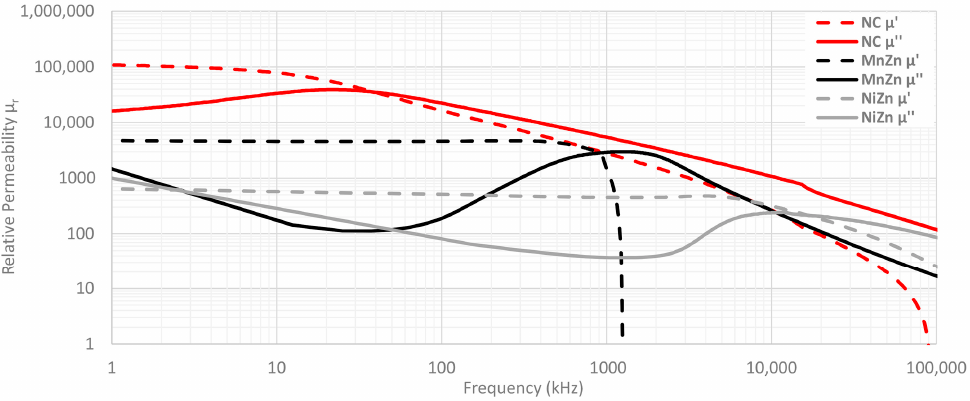
Figure 3. Complex Relative Permeability of NC, MnZn and NiZn cable ferrites compositions.